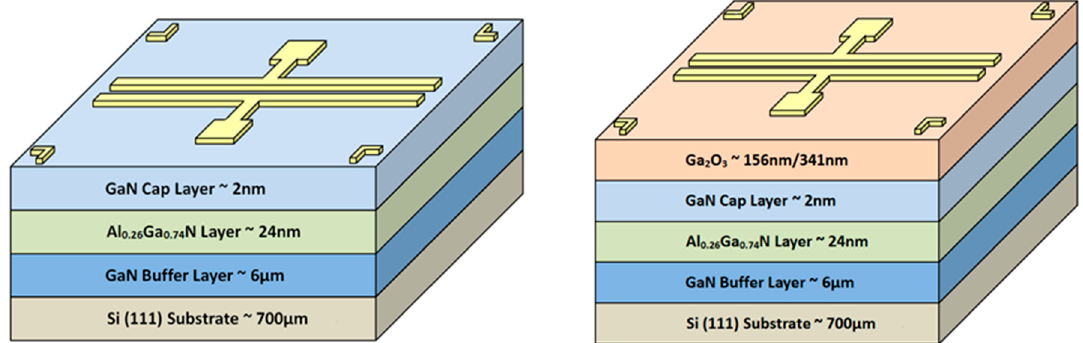
( b ) ( c ) Figure 3. Images of the ( a ) MSM varactor, ( b ) MOSOM varactor (without annealing), and ( c ) MOSOM varactor (with 900 °C annealing). ( a ) ( b ) ( c ) ( d ) ( e ) Figure 4. Optical microscope images of the ( a ) MSM varactor, ( b ) MOSOM varactor (without annealing), ( c ) MOSOM varactor (with 500 °C and 2 min of annealing), ( d ) MOSOM varactor (with 500 °C and 4 min of annealing), and ( e ) MOSOM varactor (with 900 °C and 30 min of annealing). 2.3. Measurement of the Variable Capacitance Characteristics and Breakdown Voltage Finally, to explore the effects of the heterojunction on the electrical properties of the varactor, the effects of the oxygen furnace annealing process on the improvement of the issue occurring